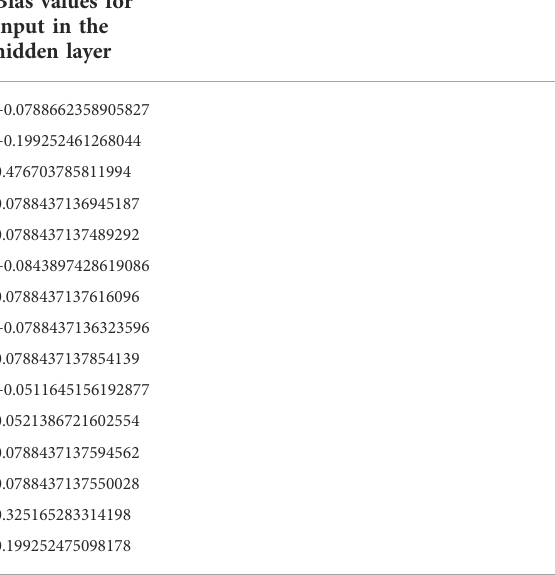
TABLE 2 Bias values of input in the hidden layer. Bias values for input in the hidden layer